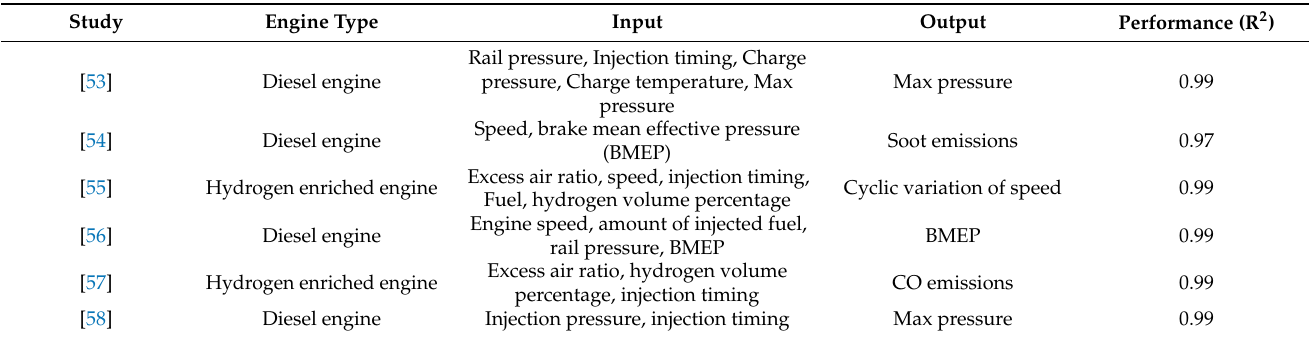
Table 1. The application of SVR model for different engine parameters prediction.